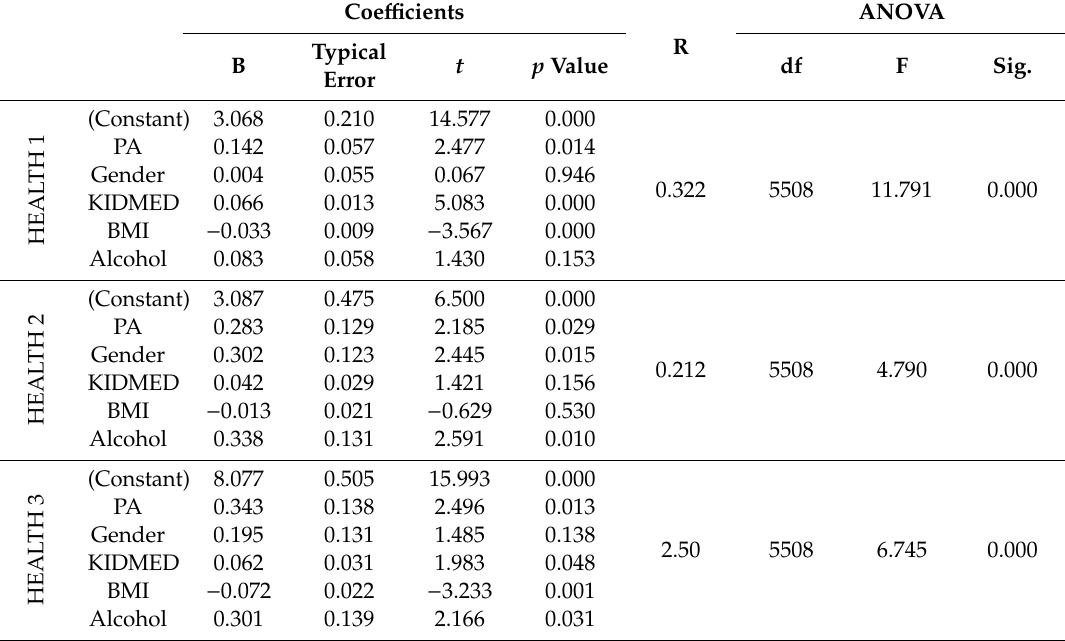
Table 2. Regression analysis between health and the level of physical activity practice, adjusted for covariates of gender, KIDMED, BMI and alcohol consumption.